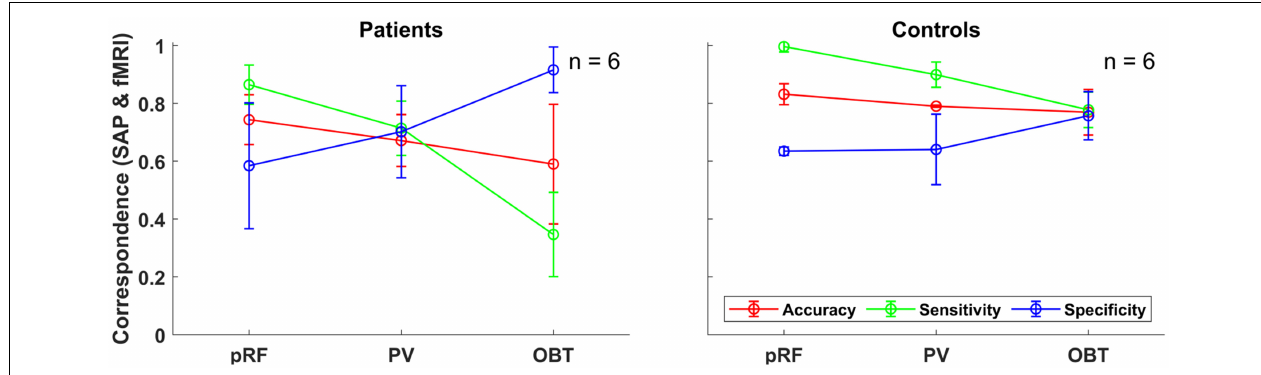
FIGURE 2 | Group-level fMRI-SAP correspondence measures (accuracy; sensitivity; and specificity) of the early visual cortex (V1–V3-pooled) for the different fMRI approaches (pRF, PV, and OBT) visualized as line plots for the patients ( n = 6) and controls ( n = 6). Each data point and error bars represent the median of the corresponding measure and its median absolute deviation (MAD) around the